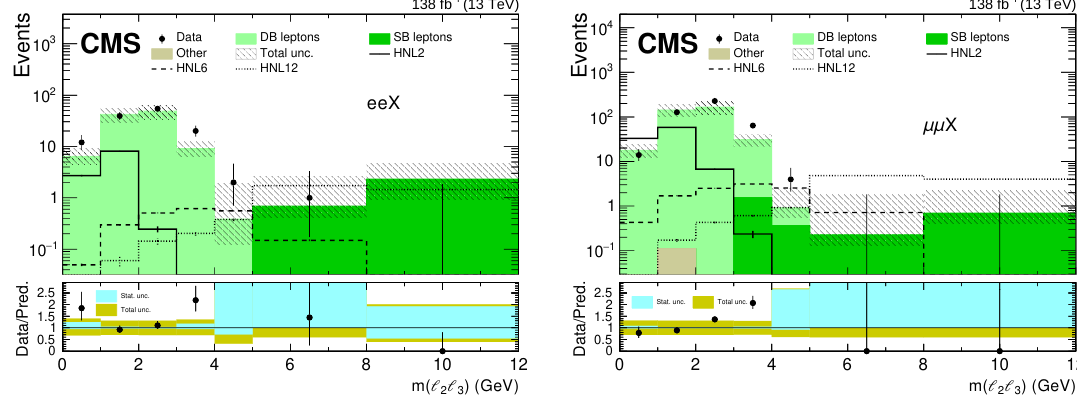
Figure 7 . Comparison between the number of observed events in data and the background pre- dictions (shaded histograms, stacked) for the m ( ‘ ) variable in eeX (left) and mm X (right) final ‘ 2 3 states. Events in the overflow bin are included in the last bin. The hashed band indicates the total systematic and statistical uncertainty in the background prediction. The lower panels indicate the ratio between data and prediction, and missing points indicate that the ratio lies outside the axis range. Predictions for signal events are shown for several benchmark hypotheses for Majorana HNL production: m = 2 GeV and | V = 6 GeV and | V | 2 = 0 . 8 × 10 − 4 (HNL2), m | 2 = 1 . 3 × 10 − 6 N N ‘ N N ‘ (HNL6), m = 12 GeV and | V | 2 = 1 . 0 × 10 − 6 (HNL12). Small contributions from background N N ‘